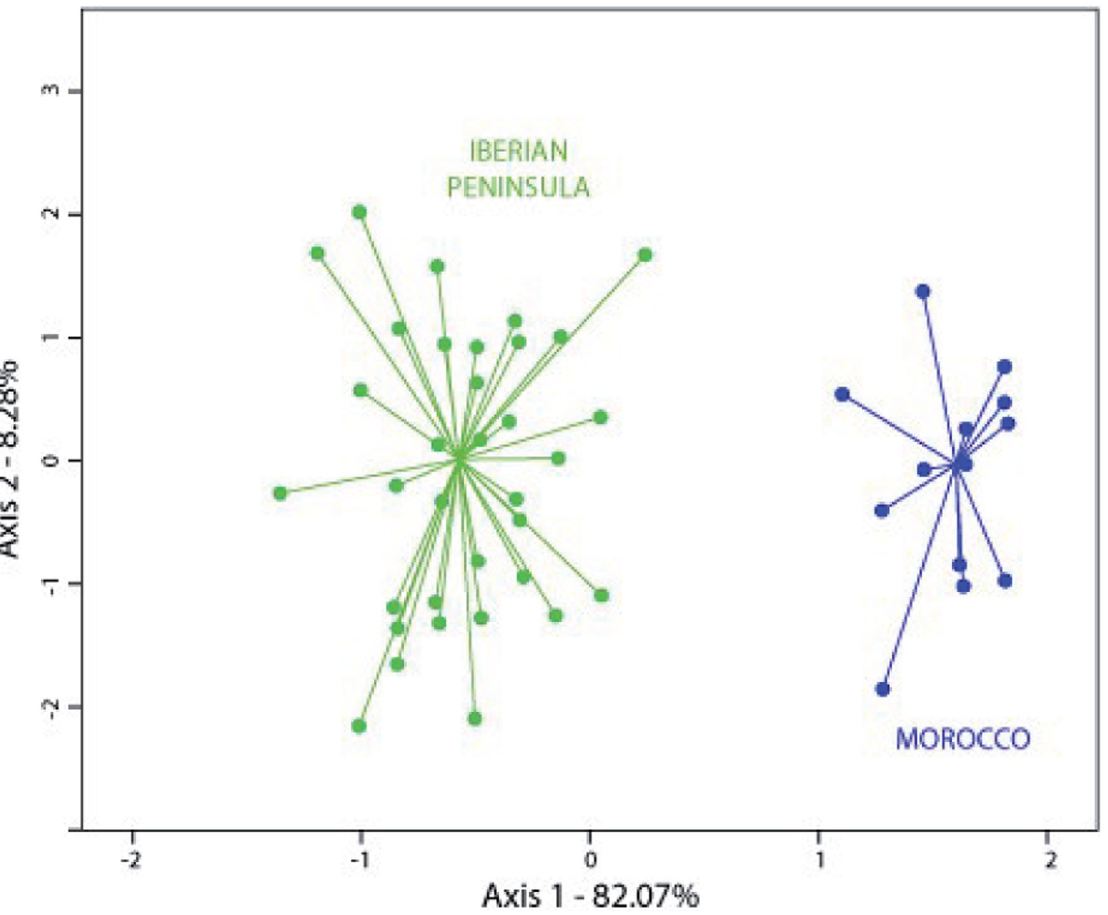
Fig 8. Scatterplot of the first two axes from the Principal Component Analysis (PCA) for the 72 individuals studied of Cynara baetica . Fifty-three individuals from the Iberian Peninsula ( C . baetica subsp. baetica , in green) and 19 individuals from Morocco ( C . baetica subsp maroccana , in